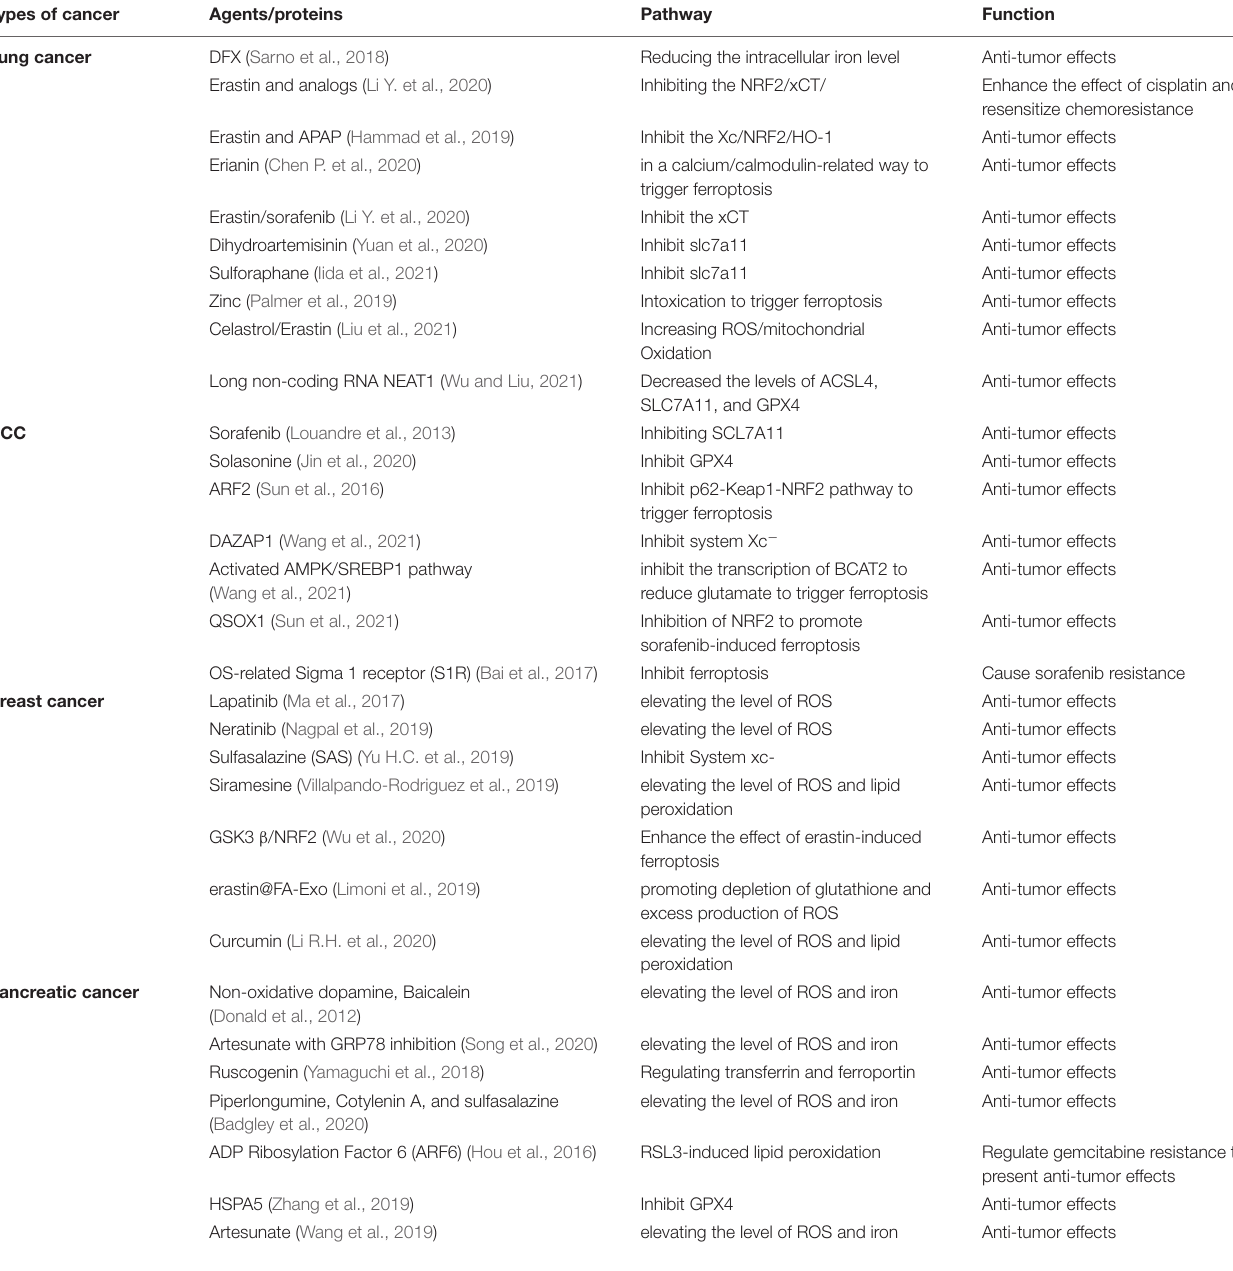
TABLE 1 | Overview of pathways and functions of ferroptosis-associated agents and